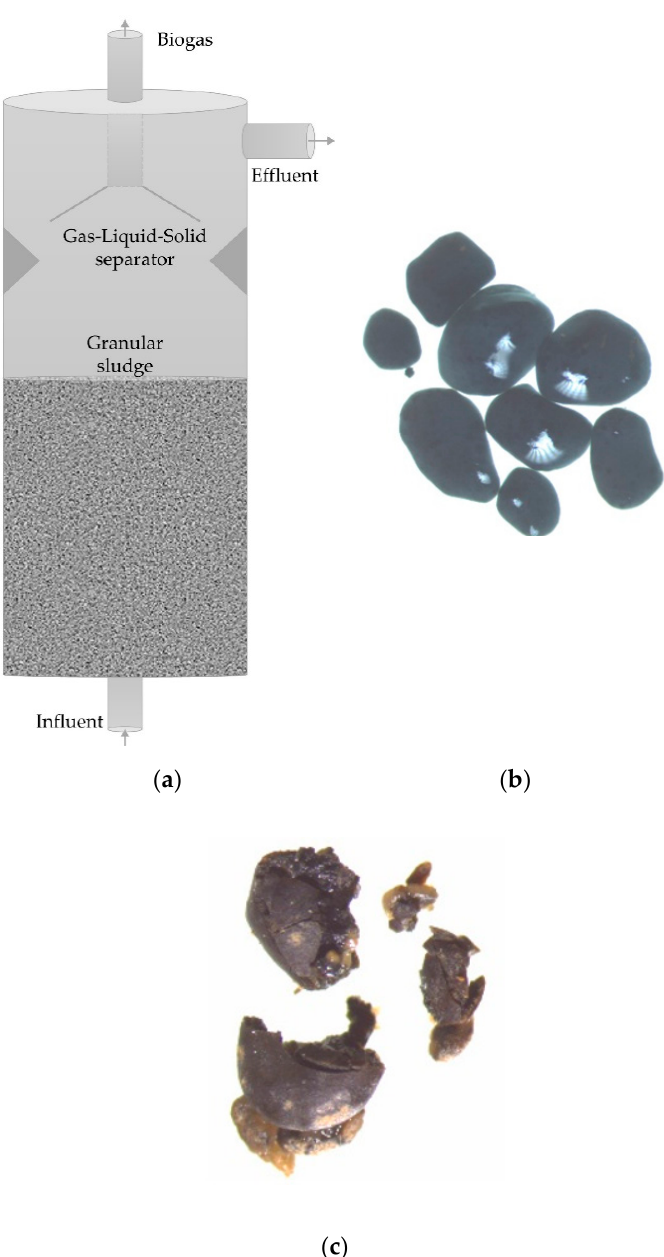
Figure 1. Up-flow anaerobic sludge bed (UASB) reactor components ( a ) and examples of granular sludge ( b and c ).